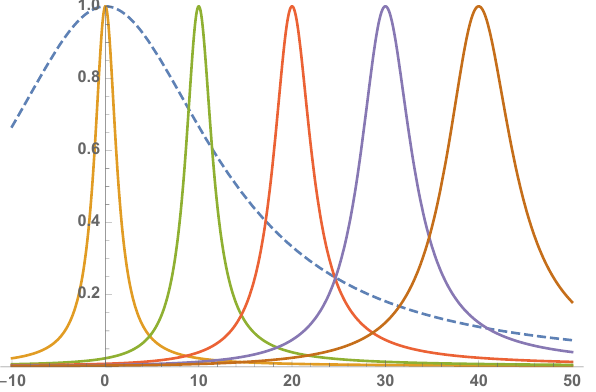
Figure 2. DOC µ ( x 1 , x ) vs. x with x 1 = 0,10, . . . ,40, for T = 1, σ = 10, δ = 1 (from left to right). The dashed curve is the normalized